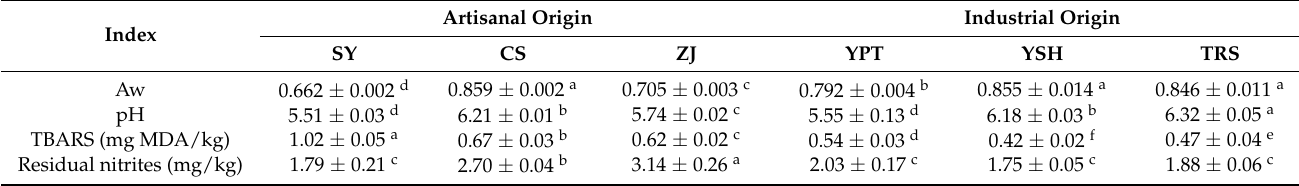
Table 1. Aw, pH, residual nitrite content and TBARS values in Larou of artisanal and industrial